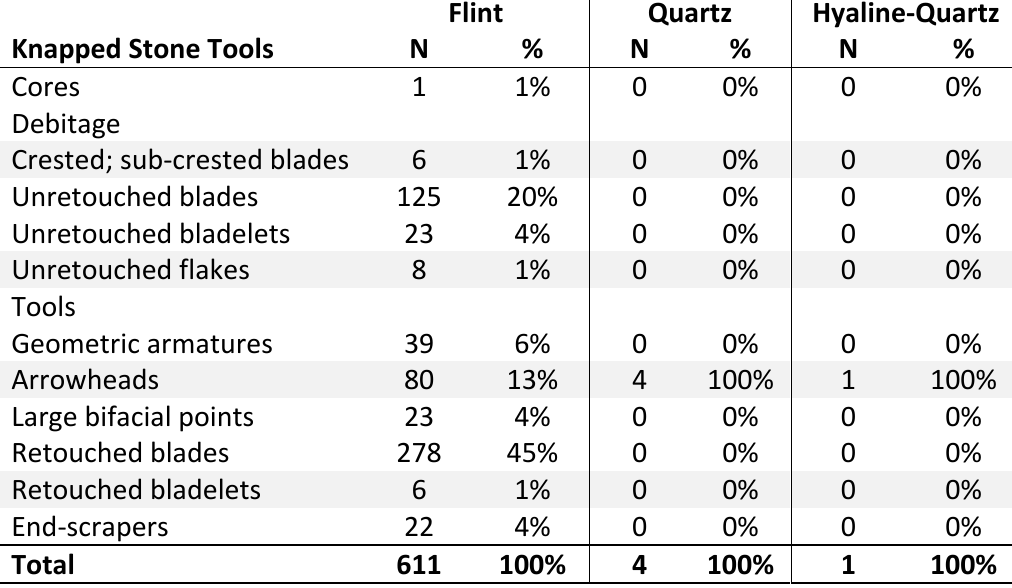
Flint Quartz Hyaline-Quartz Knapped Stone Tools N %